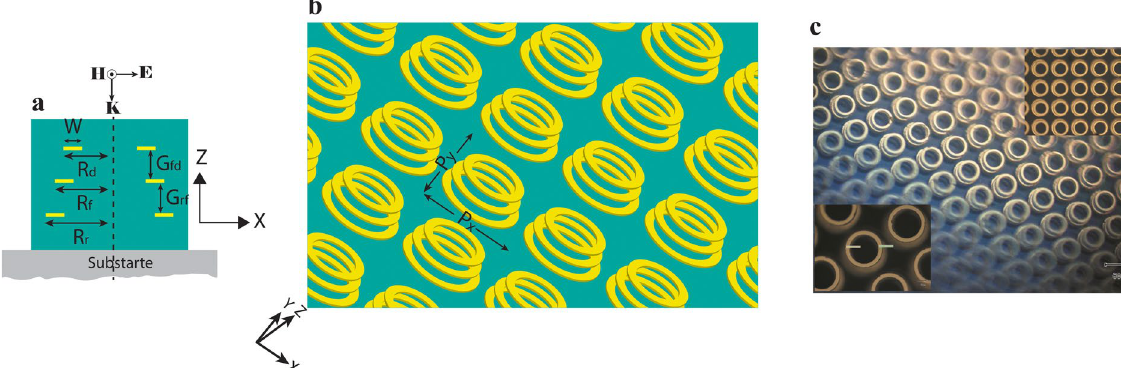
Figure 1. ( a ) Single unit of Yagi-Uda (side view). ( b ) Yagi-Uda array. ( c ) Optical microscope image of fabricated sample (inset: front views).